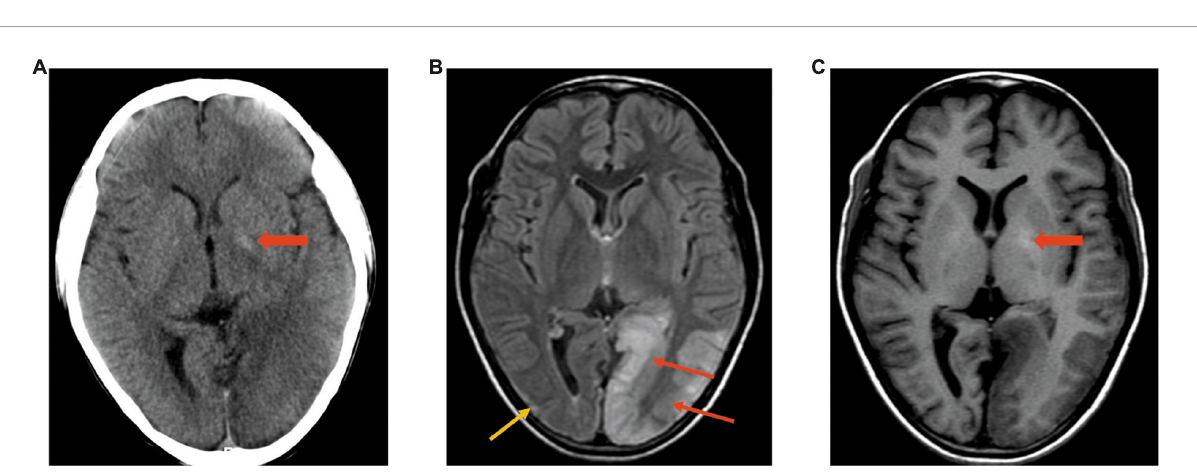
FIGURE4 Polymorphism of lesions. Case 5, A 12-year-old boy with MELAS. (A) CT image. Density decreases in the left occipital lobe; calcification is slightly evident on the left (wide arrow). (B,C) MRI was performed after 3 days in the same boy. FLAIR (B) showed polymorphism of the lesion: Cortex swelling on the left occipital (red arrows) and cortex atrophy with gliosis (yellow arrow) on the right occipital. T1WI (C) showed hyperintensity in the bilateral basal ganglia and hypointensity in the left occipital